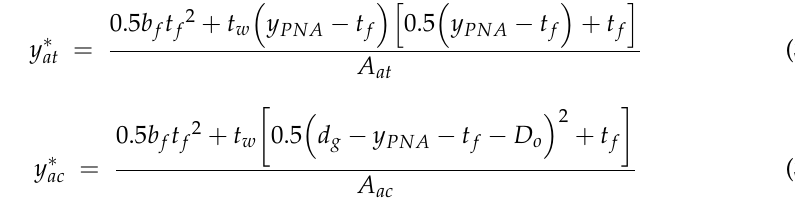
Finally, the distances d 1 , d 2 , and d 3 are obtained according to Equations (38)–(40), in which c is the distance between the geometric center of the reinforcement bars and the I-section upper